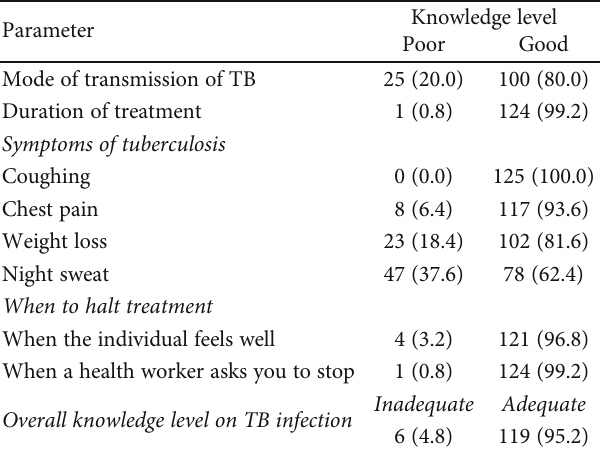
Table 3: Chi-square test analysis of factors associated with treatment